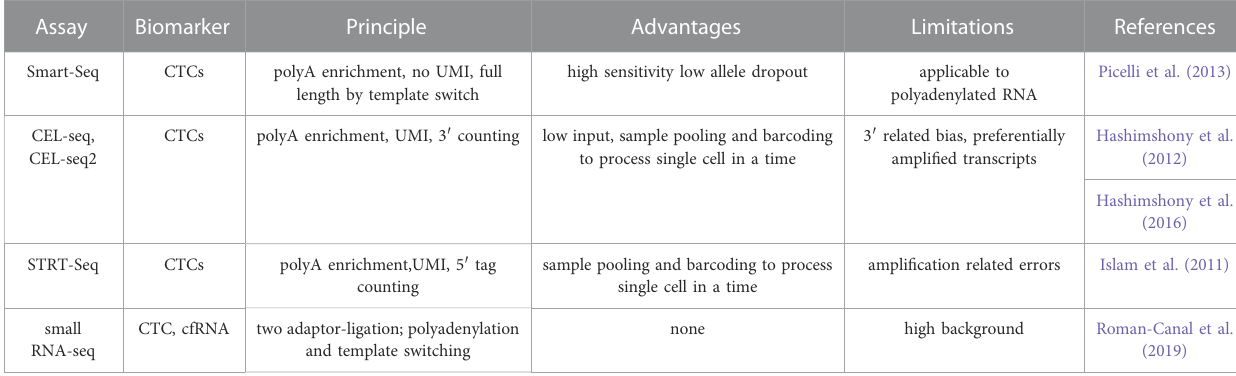
TABLE 3 Overview of techniques to study gene expression changes in liquid biopsy.